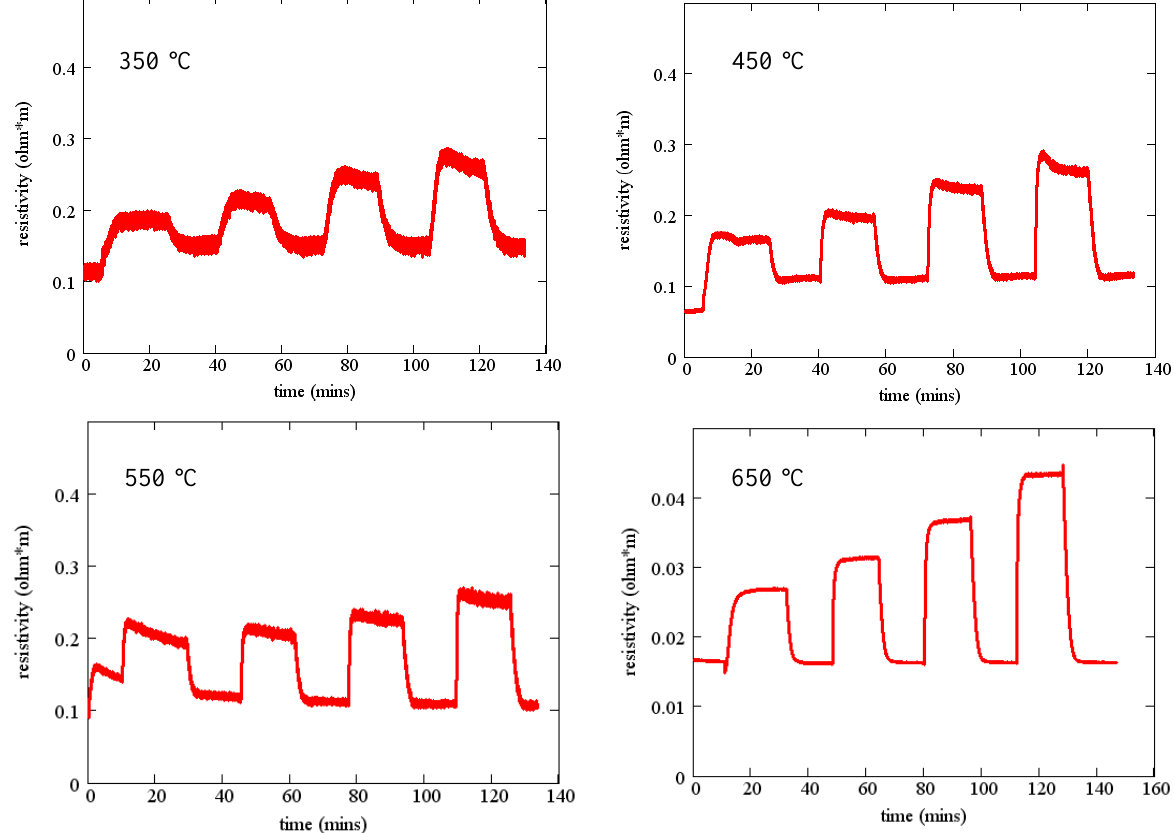
Figure 12. Resistivity as a function of time for SnO shows the resistivity as a function of time when the oxygen concentration is varied according to Figure